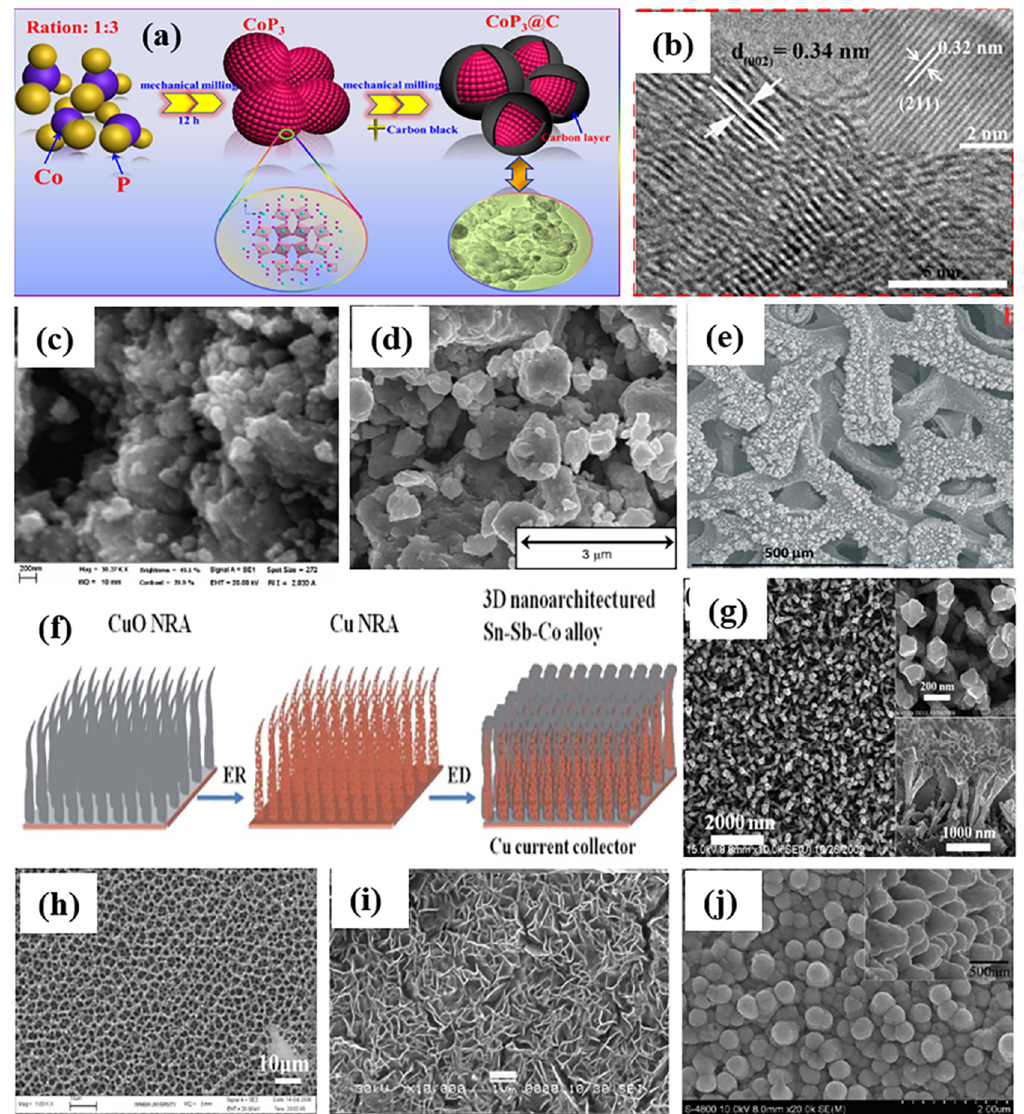
Figure 7. Preparation methods and morphology characterizations of cobalt-based composites. ( a ) Schematic illustration of the preparation of CoP 3 @C microspheres. ( b ) HRTEM image of the CoP 3 @C composite [80]. ( c ) SEM image of the SnCoC-2 sample [34]. ( d ) SEM image of the Sn 30 Co 30 C 40 material [81]. ( e ) SEM image of the Co-Sn alloy after electrodeposition [84]. ( f ) Schematic illustration of the preparation of the Sn-Sb-Co alloy. ( g ) SEM images of the SnSbCo-3 electrode; the insets show a corresponding high-magnification image (top-right) and cross-sectional photos of the electrode (bottom-right) [85]. ( h ) SEM image of the porous SnCo alloy [86]. ( i ) SEM image of Co 3 O 4 thin films synthesized by electrochemical deposition [87]. ( j ) SEM image of the Sn-Co alloy deposited on a Ni nanocon-array [38].